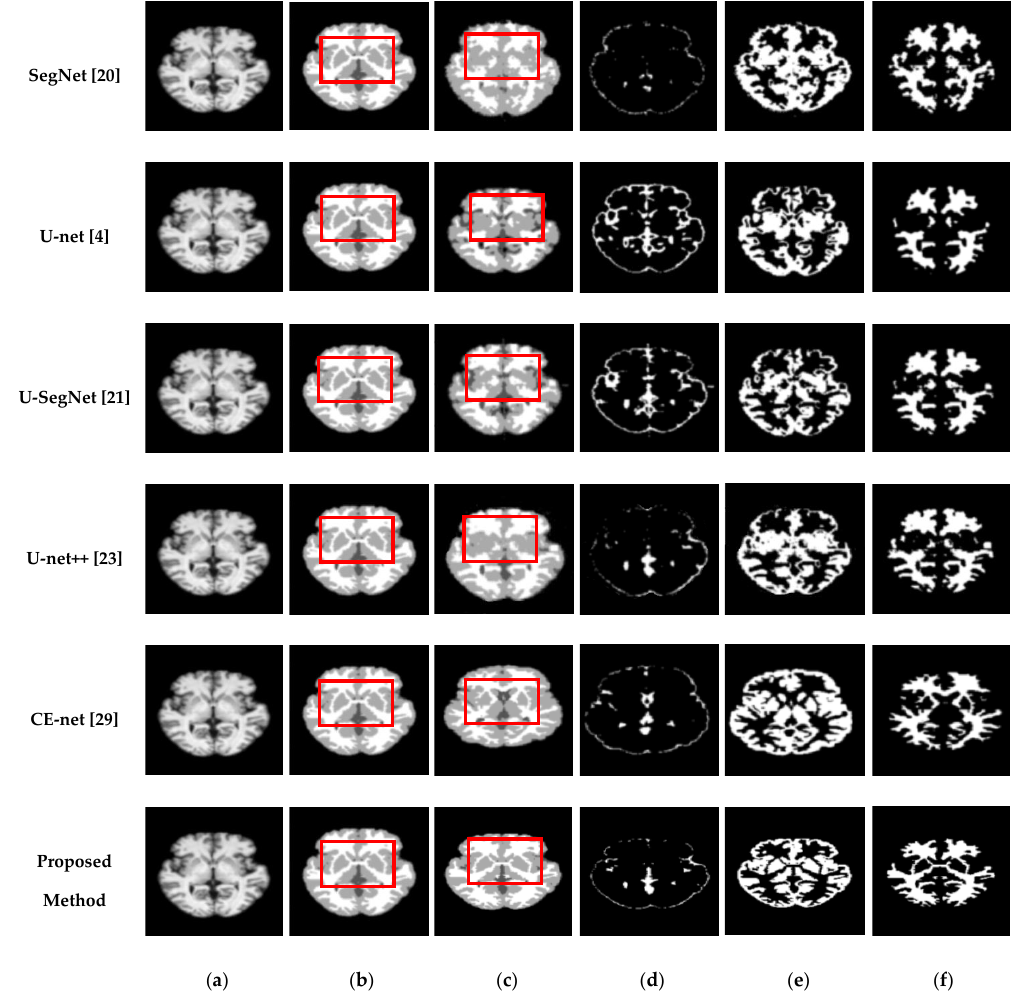
Figure 8. Segmentation results for GM, CSF, and WM from brain MRI image using the existing methods and the proposed method on IBSR dataset: ( a ) original input image; ( b ) ground-truth segmentation map; ( c ) their segmentation results obtained SegNet, U-net, U-SegNet, U-net++,CE-net, and the proposed method (top to bottom); ( d ) CSF maps obtained by SegNet, U-net, U-SegNet, U-net++,CE-net, and the proposed method (top to bottom); ( e ) GM maps obtained by SegNet, U-net, U-SegNet, U-net++,CE-net, and the proposed method (top to bottom); ( f ) WM maps obtained by SegNet, U-net, U-SegNet, U-net++,CE-net, and the proposed method (top to bottom).